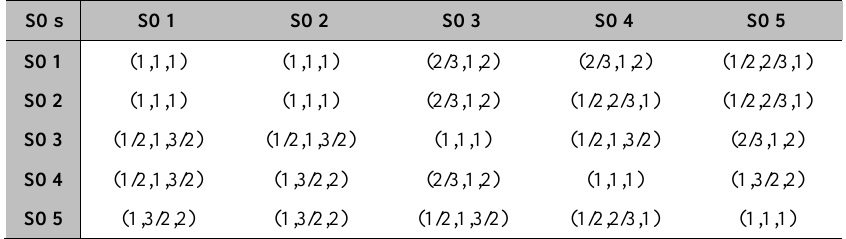
Table 3: Fuzzy comparison matrix of the five strategic objectives with respect to the objective